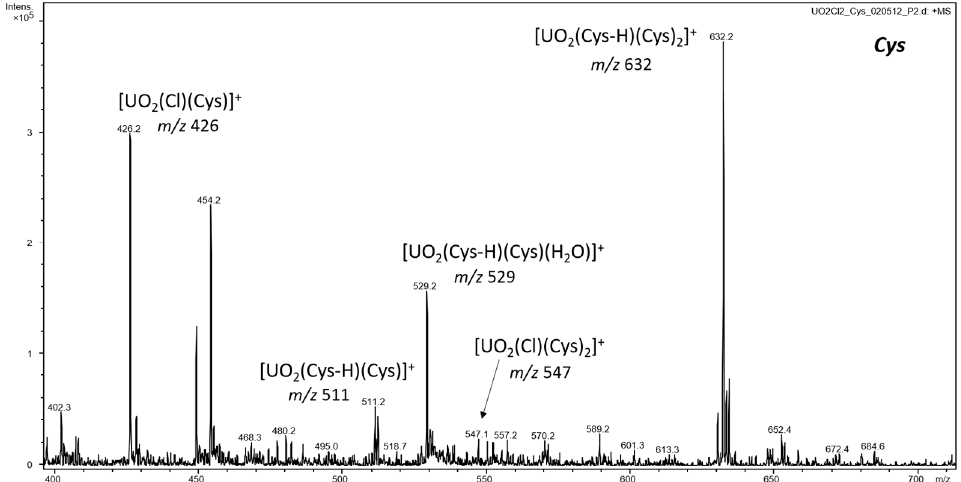
Figure 1. ESI-MS of a uranyl chloride + cysteine solution (1:4) in positive ion mode.